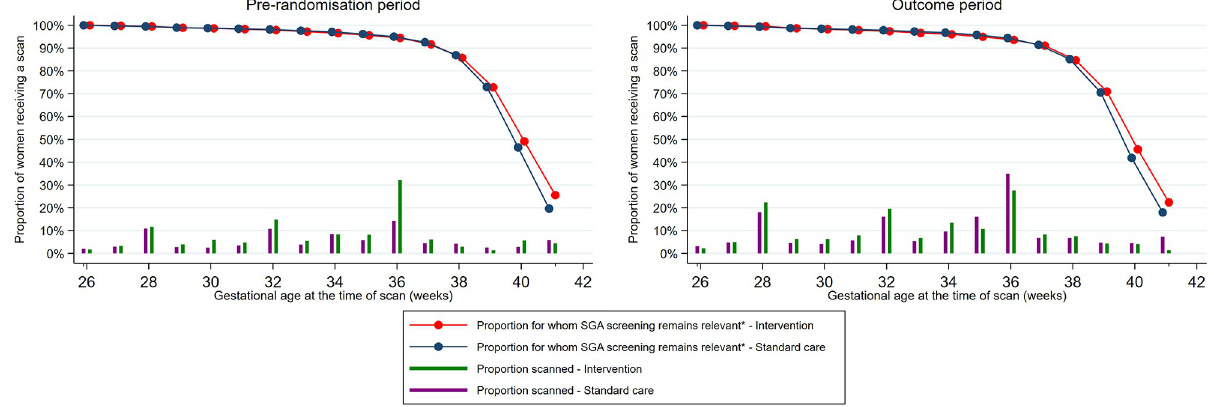
Fig 2. Ultrasound utilisation per week of gestation in standard care and intervention arms during the prerandomisation and comparison periods. SGA, small for gestational age. � Pregnancies for which SGA screening remained relevant for each week gestation was defined as ongoing pregnancies (undelivered) that had not been antenatally detected as SGA (growth scans with estimated fetal weight > 10th centile or no growth scans) up to that gestational